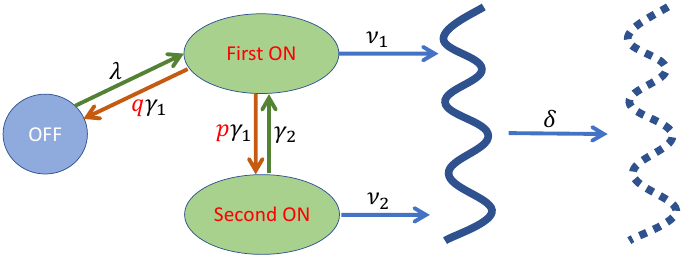
Figure 1. The stochastic transition of transcription with two active states and one inactive